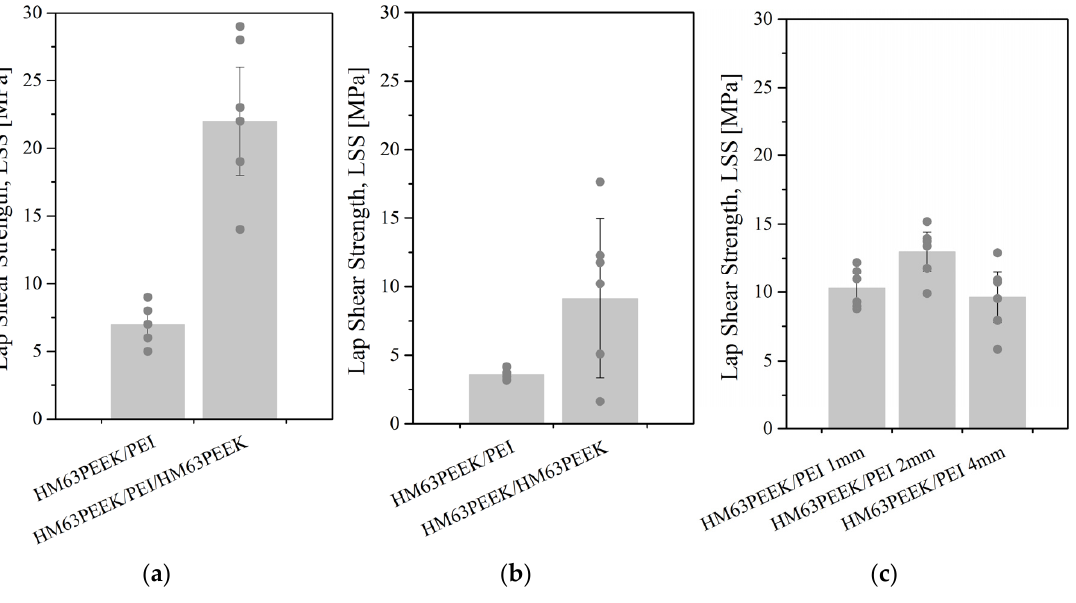
Figure 12. Lap shear strength of test specimens after ( a ) ultrasonic, ( b ) induction and ( c ) transmission laser welding. LSS is calculated from the effective welded surface.